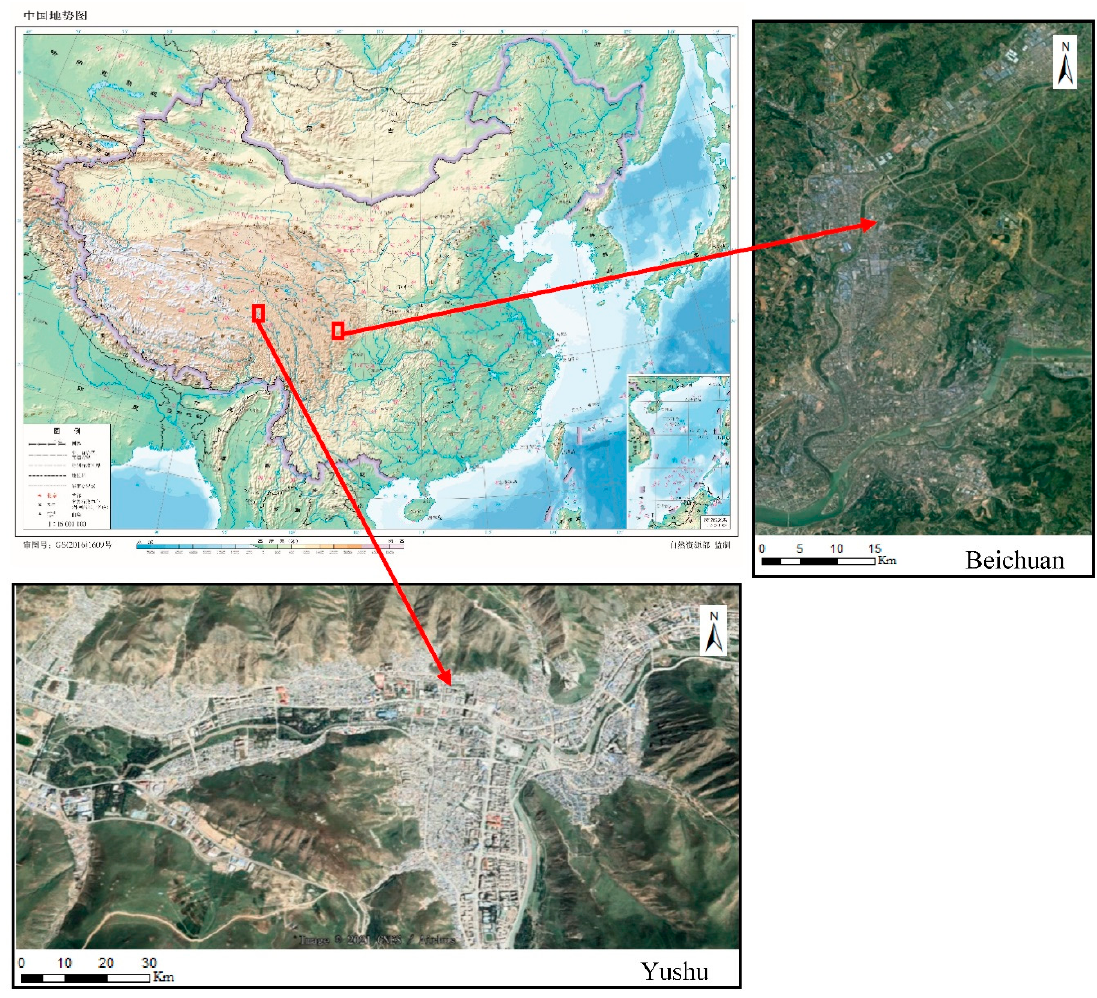
Figure 1. Location of the study areas.